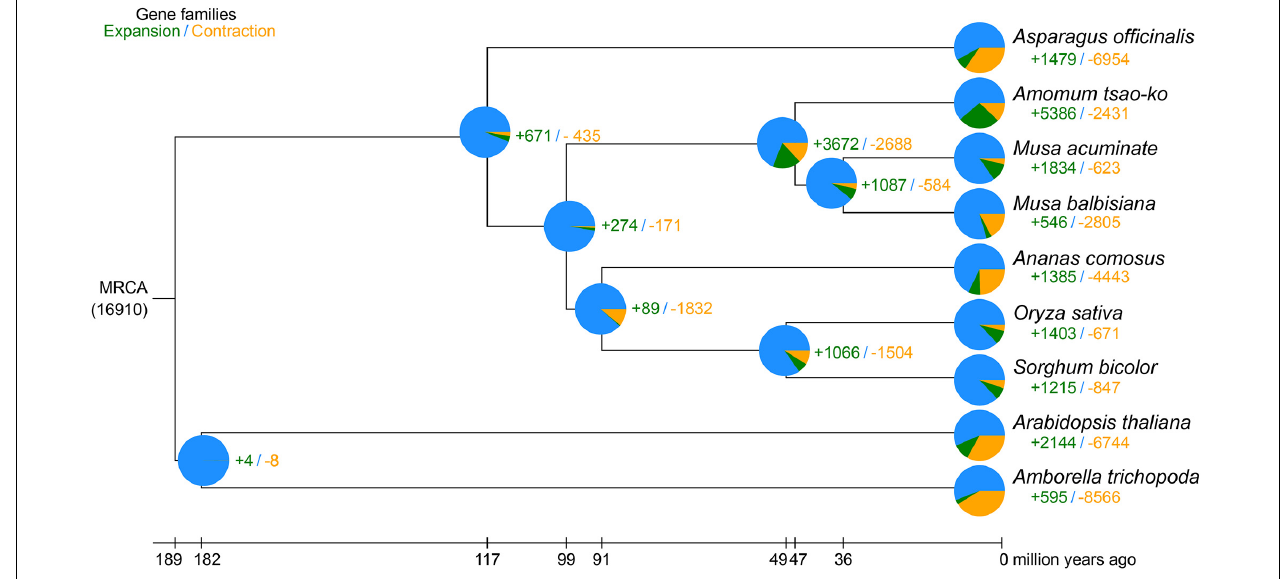
FIGURE 3 | Phylogeny of A. tsao-ko and gene family analysis. The numbers in green represent the expanded gene families, the numbers in yellow represent the contracted gene families. MRCA, most recent common